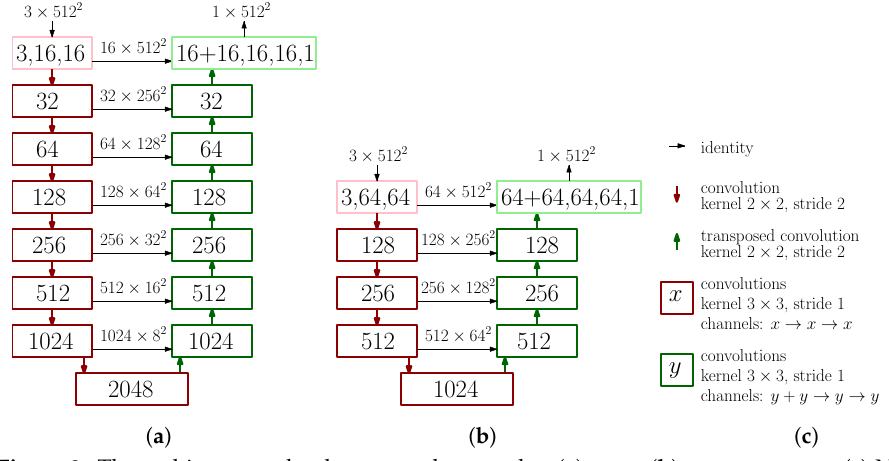
Figure 2. The architectures the deep neural networks. ( a ) CROP . ( b ) CROP-Shallow . ( c ) Notations. ReLU and batch normalization are applied adequately, which are not explicit in the